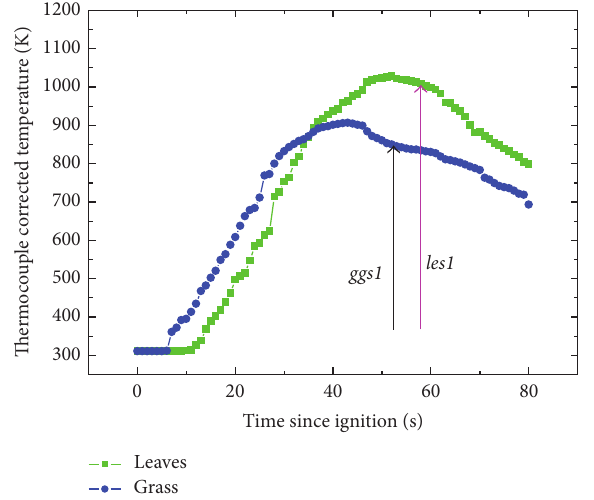
Figure 2: Eucalyptus litter fires temperature during the